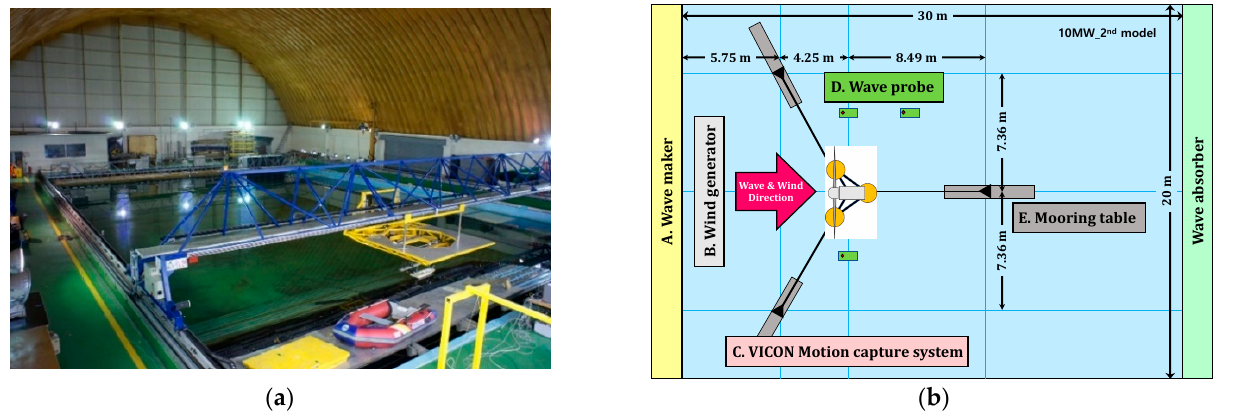
Figure 3. ( a ) Test facility, Ocean Engineering Widetank, University of Ulsan; ( b ) Test model install configuration.